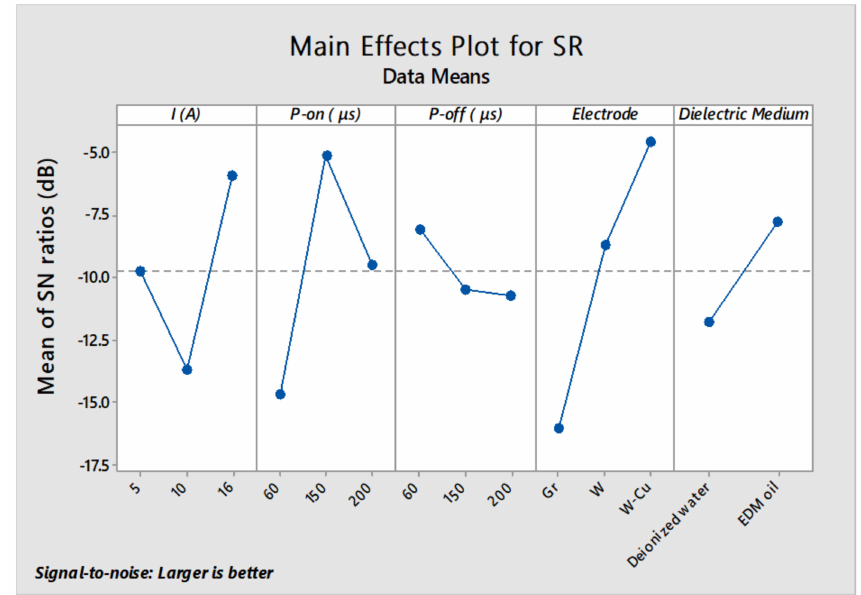
Figure 3. Main e ff ect plot for S / N ratios of Surface Roughness.